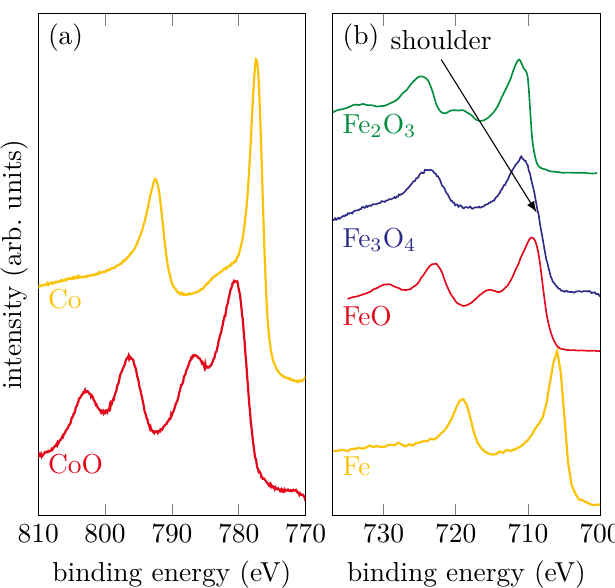
Figure 1. Reference spectra of ( a ) metallic Co and CoO samples and ( b ) metallic Fe and different iron oxide